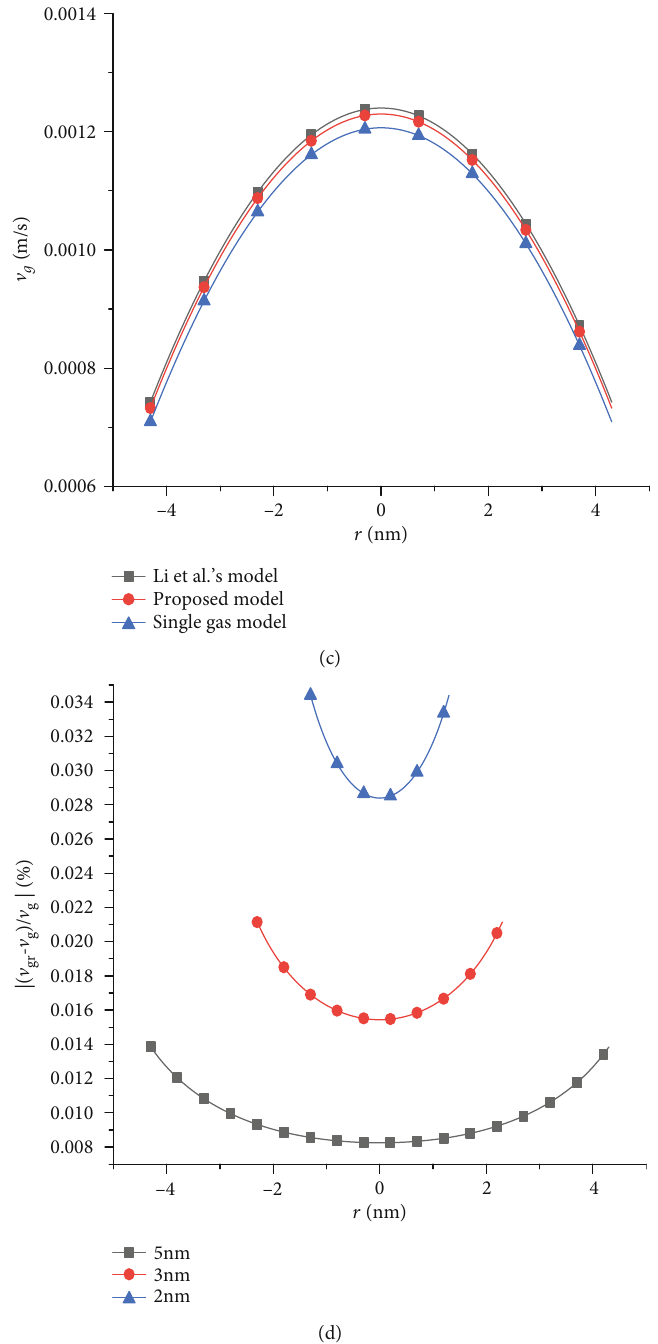
Figure 5: Comparison between the proposed model, single gas model, and Li et al. ’ s model [22] at di ff erent pore radii of 1 nm, 2 nm, and 4nm. V is the velocity in Li et al. ’ s paper. P = 50 MPa, T = 350 K, ∅ = 0 : 9 , h gr = 2 nm ; (b) gas velocity pro fi le comparison at r Gas velocity pro fi le comparison at r 0 nm ; (d) the relative di ff erences between Li et al. ’ s model and the proposed